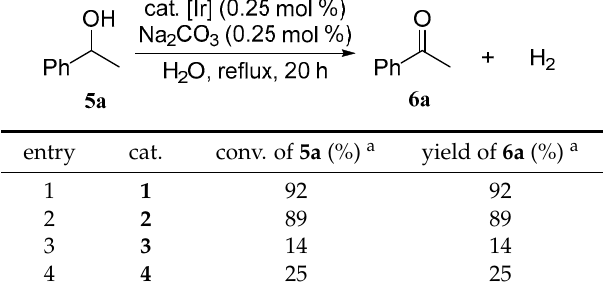
Table 1. Dehydrogenative oxidation of 1-phenylethanol ( 5a ) to acetophenone ( 6a ) in aqueous media using water-soluble iridium complexes 1 – 4 .